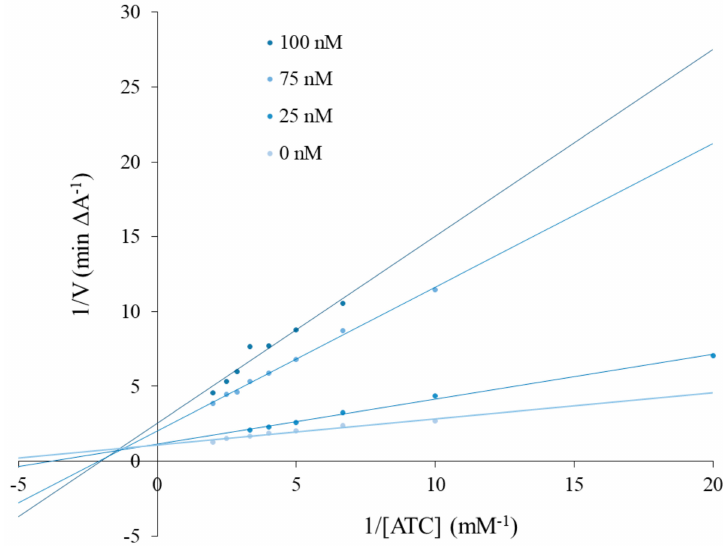
Figure 1. Lineweaver–Burk reciprocal plots of initial velocity and without the presence of inhibitor 3c (three concentrations), illustrating the mixed nature of Ee AChE inhibition.